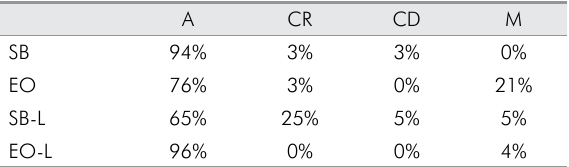
Table 4. Failure mode distribution (%) for each group.